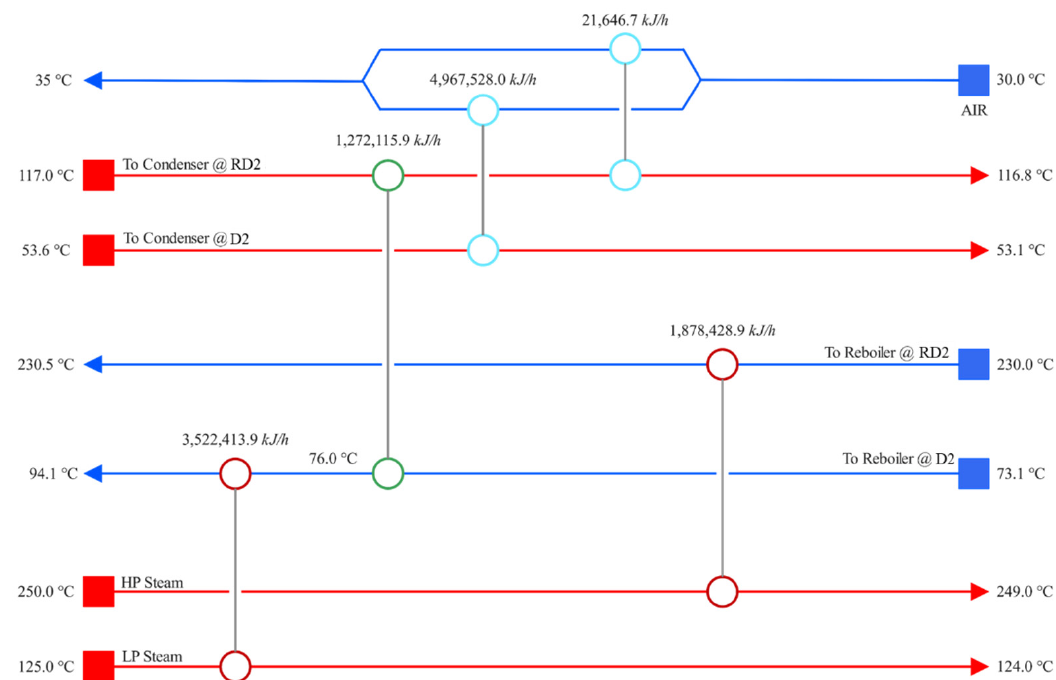
Figure 9. Detailed HEN between RD and DWC. Red lines are hot stream, blue lines are cold stream, and green circle is heat integration connection.